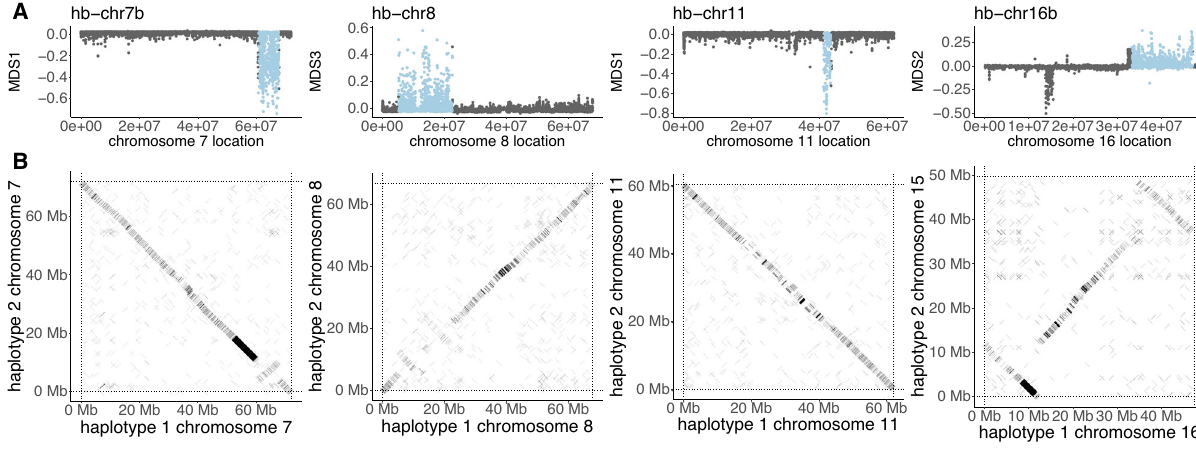
Fig. 4 | Population-genomic signatures of inversions correspond to inversions segregating in the diploid reference. A Divergent local population structure identi fi es putative inversions (pale blue regions) from population-genomic data.